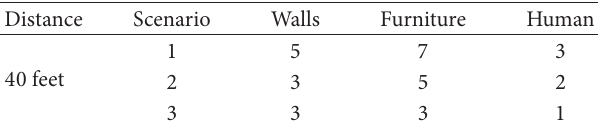
Table 7: Case 4 of experimental